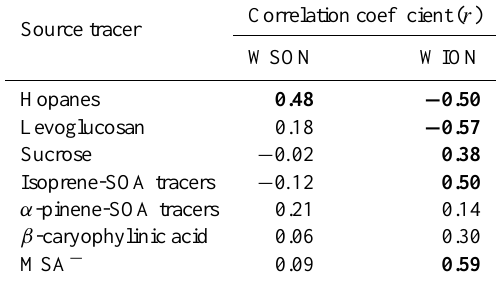
Table 3. Spearman’s rank correlation of WSON and WION with source tracers in Sapporo aerosols during the study period ( n = 21). Significant correlation coefficients at 0.05 level are shown in